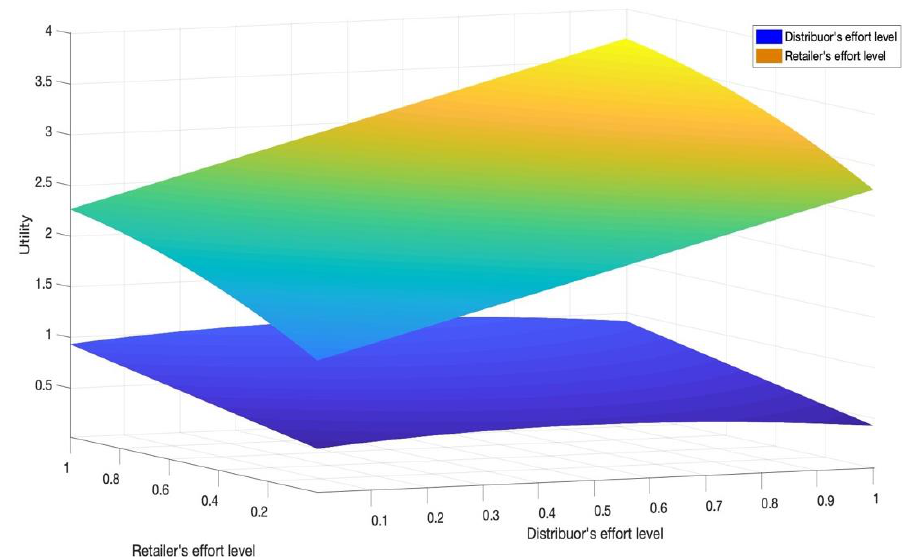
Figure 2. The effects of the effort level of distributors and retailers on supply chain profit.